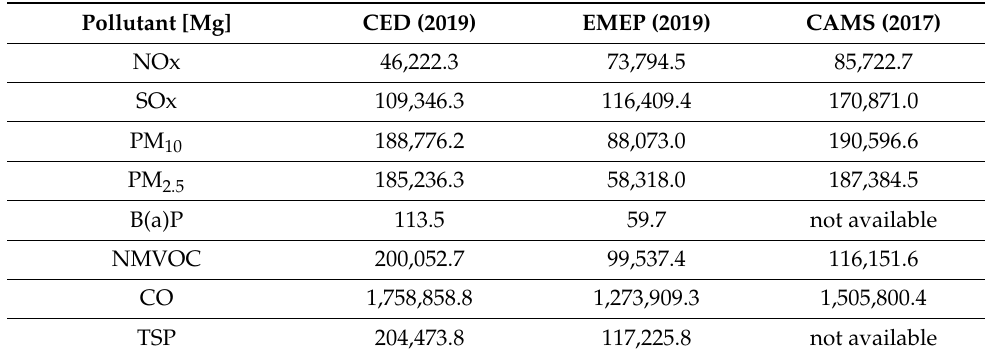
Table 3. Country totals for the compared inventories from the residential